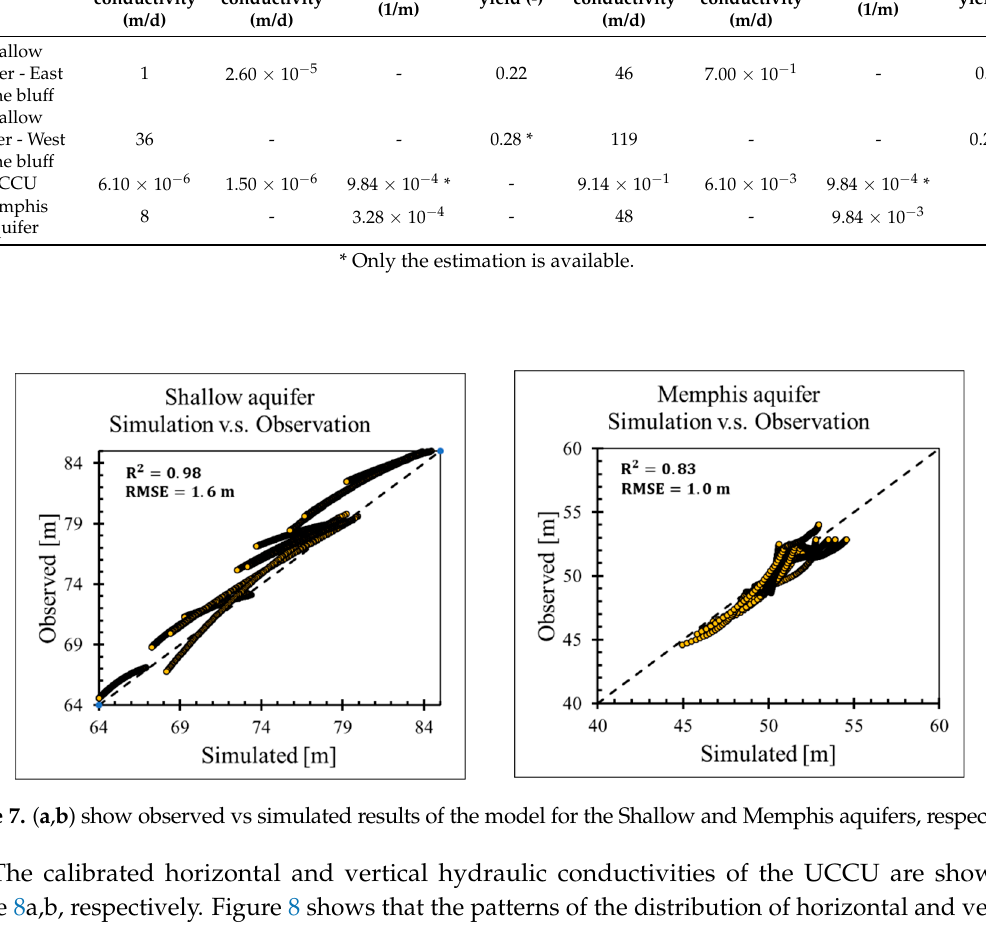
Figure 7. ( a , b ) show observed vs simulated results of the model for the Shallow and Memphis aquifers, respectively.